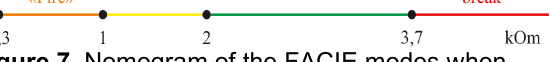
Figure 7. Nomogram of the FACIE modes when working with detectors with contacts that are closed and verified by two